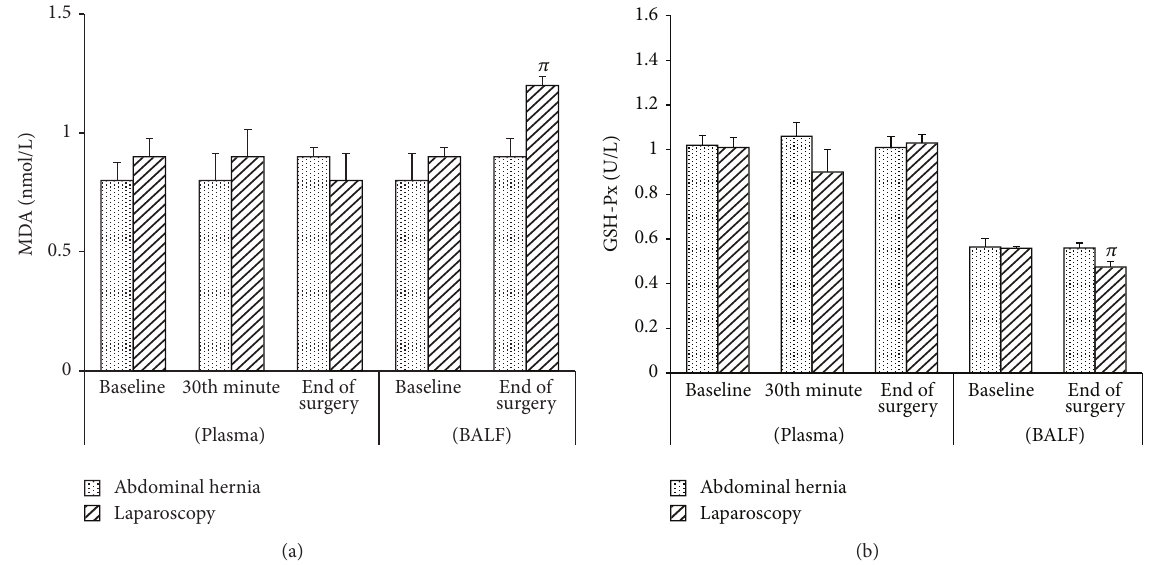
Figure 3: Pre- and perioperative MDA (malondialdehyde) (a) and GSH-Px (glutathione peroxidase) (b) levels of the groups in plasma and BALF. Data are expressed as mean ± standart error. 𝜋 𝑃 < 0.05 compared to BALF